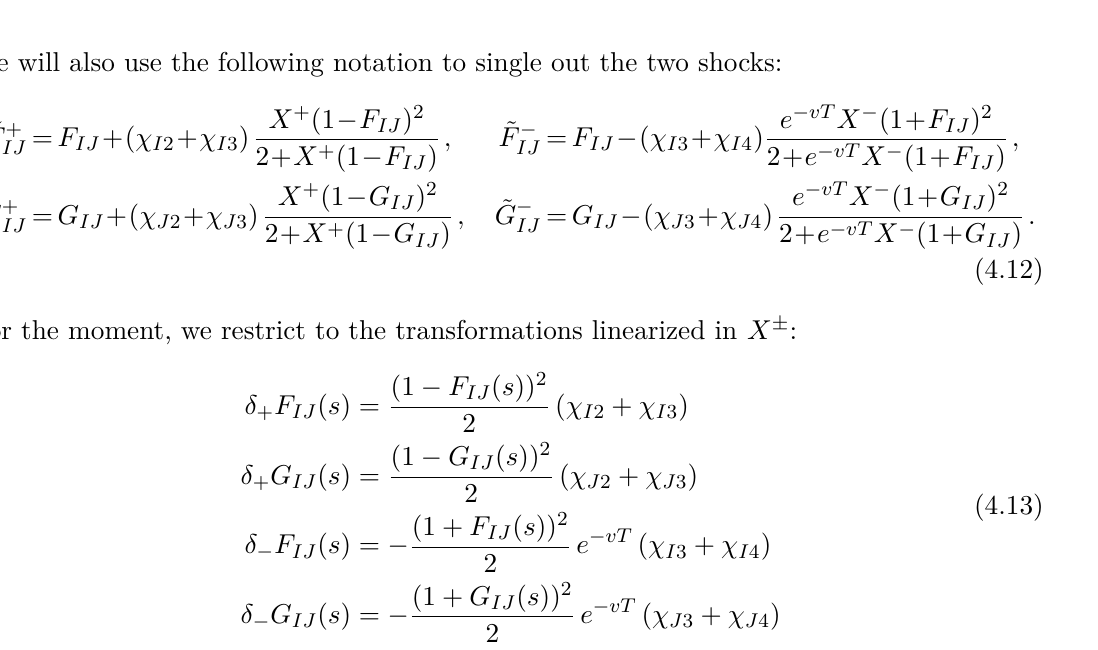
Figure 3 . The bilocal version of figure 2, as required for the large q SYK model. Shaded regions show where the fluctuations δ ± g ( s 1 , s 2 ) have non-zero support. By symmetry, we can always focus on the triangle s 1 > s 2